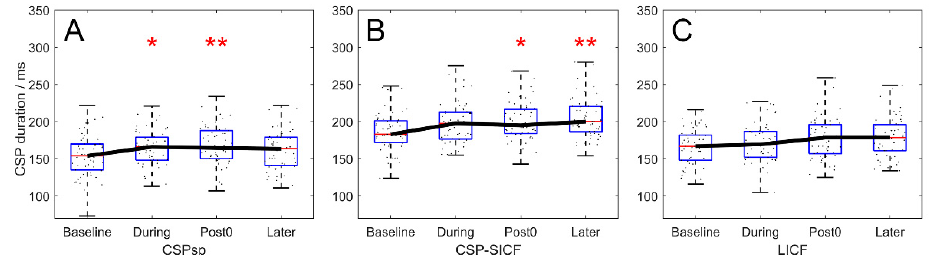
Figure 3. Chronological modulation of CSP duration by 20-Hz rTMS, in the real-rTMS group. ( A ) modulation of CSP sp . ( B ) modulation of CSP SICF . ( C ) modulation of CSP LICF . CSP sp demonstrated significant prolongation at the During and Post timepoints, while CSP SICF and CSP SICF showed significant prolongation at the Post and Later timepoints. The prolongation of CSP LICF was not significant. Boxes denote 25th and 75th percentile values, whiskers denote minimum and maximum values. Asterisks denote significant difference compared to the Baseline timepoint. * p < 0.05; ** p <